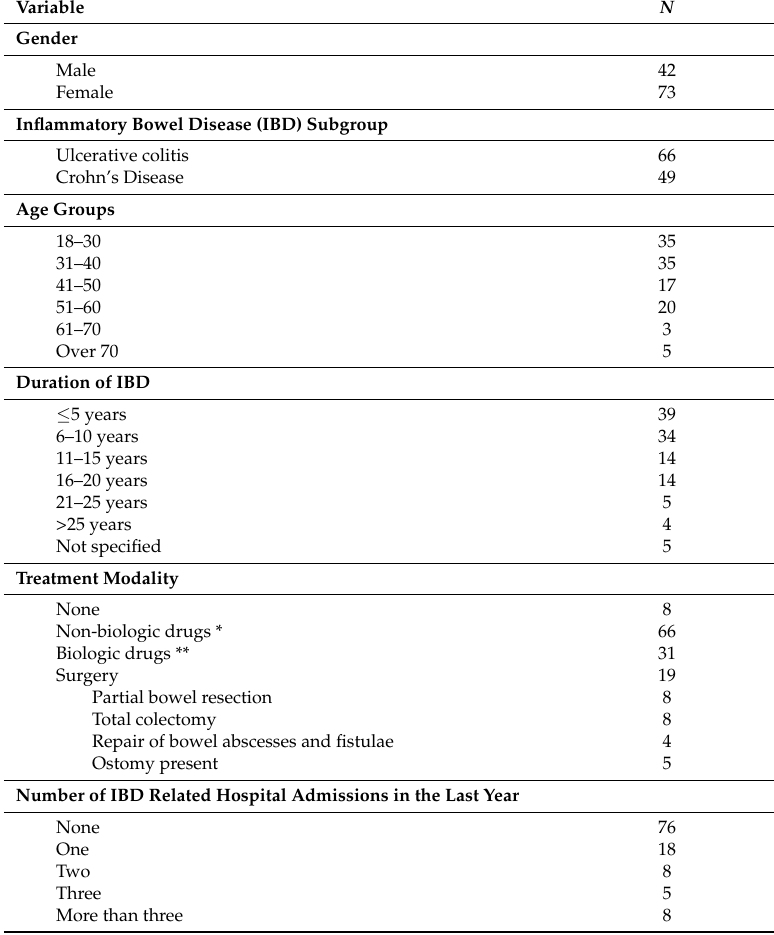
Table 1. Demographic and clinical details of the